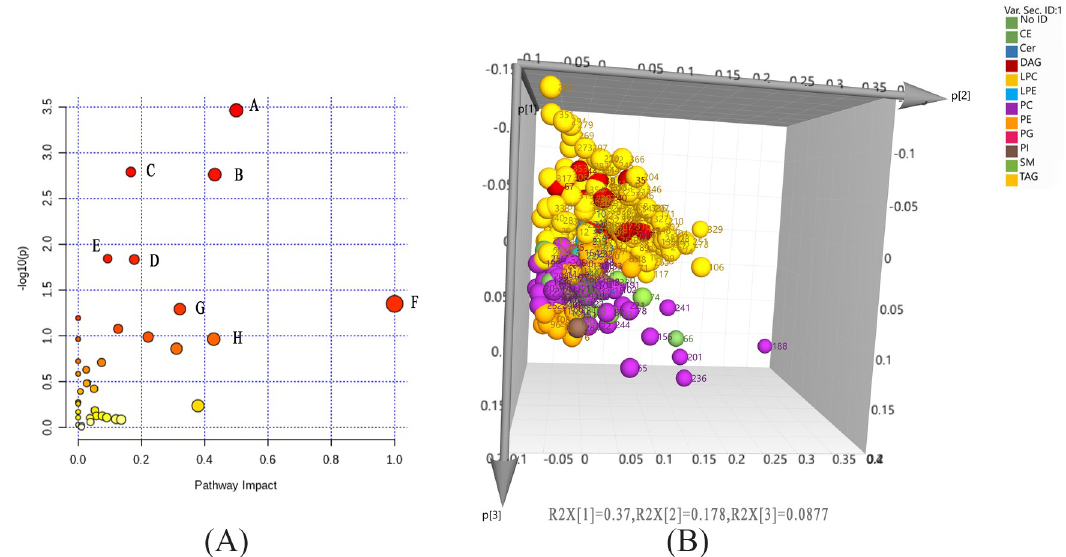
Fig 4. Graphical representation of the pathway analysis of significantly altered metabolites in the three groups (A: metabolomic results; B: lipidomic results). A:D-glutamine and D-glutamate metabolism; B: glycine, serine and threonine metabolism; C: aminoacyl-tRNA biosynthesis; D: arginine metabolism; E: sphingolipid metabolism; F: linoleic acid metabolism; G: arginine and proline metabolism; H: taurine and hypotaurine metabolism. LPC: lysophosphatidylcholine; SM: sphingomyelin; TAG, triacylglycerol. Dark bule circle: cluster of LPC metabolites; red circle: cluster of SM metabolites; light blue circle: cluster of TAG metabolites.